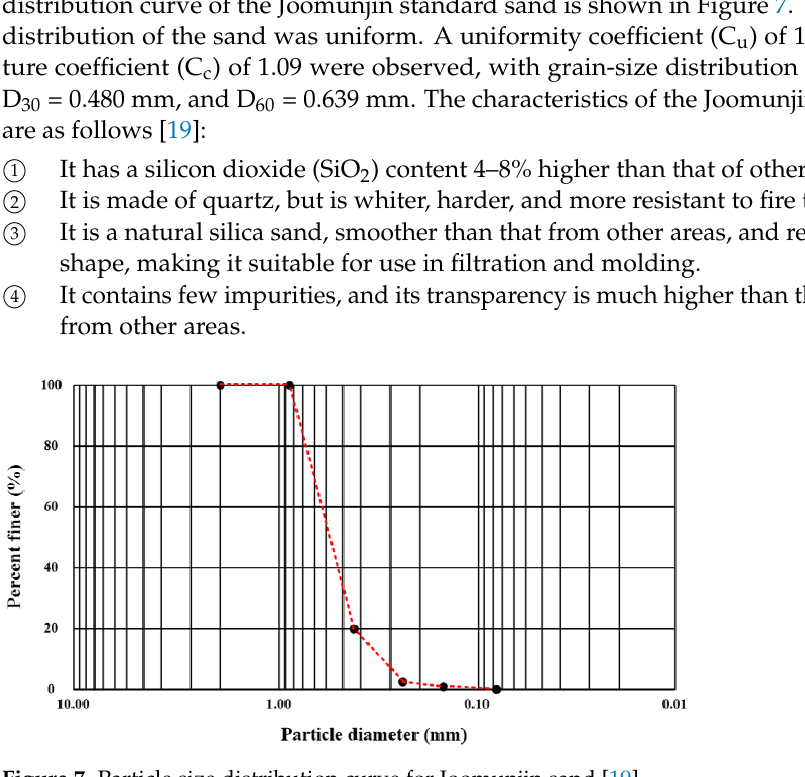
Figure 7. Particle size distribution curve for Joomunjin sand [19].